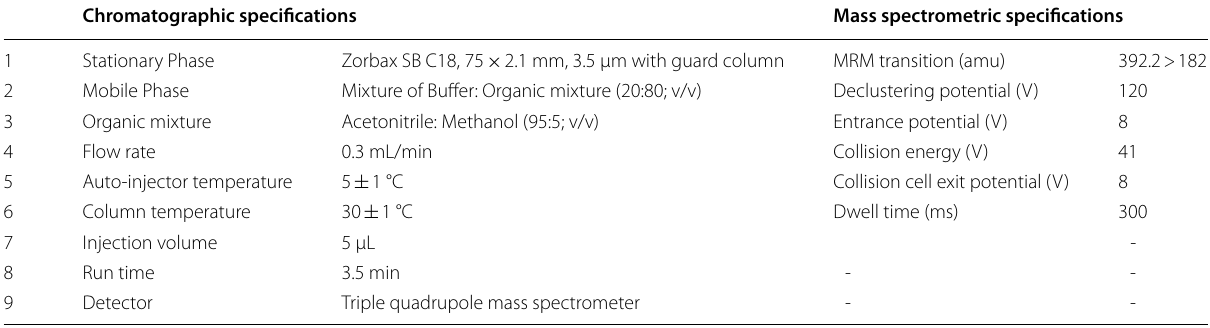
Table 5 Parameters for analytical method development for in vivo estimation of trospium chloride Chromatographic